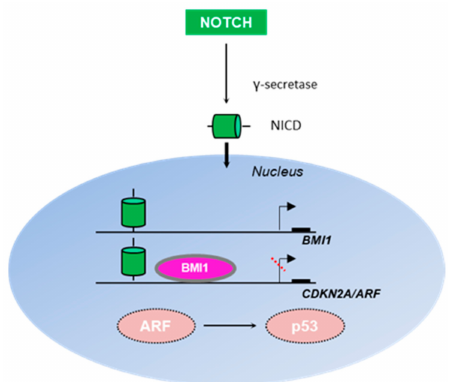
Figure 2. Interplay between the Notch and ARF/p53 signaling pathways. Notch is a transmembrane receptor, which upon cleavage by γ -secretase produces an intracellular domain (NICD) capable of translocating to the nucleus and directly regulating gene transcription. BMI1 is activated by Notch to regulate cellular proliferation and stem cell self-renewal, especially in neural tissue [108]. Both Notch and Bmi1 directly occupy the Arf promoter to repress Arf expression [108], thus perturbing Arf- mediated p53